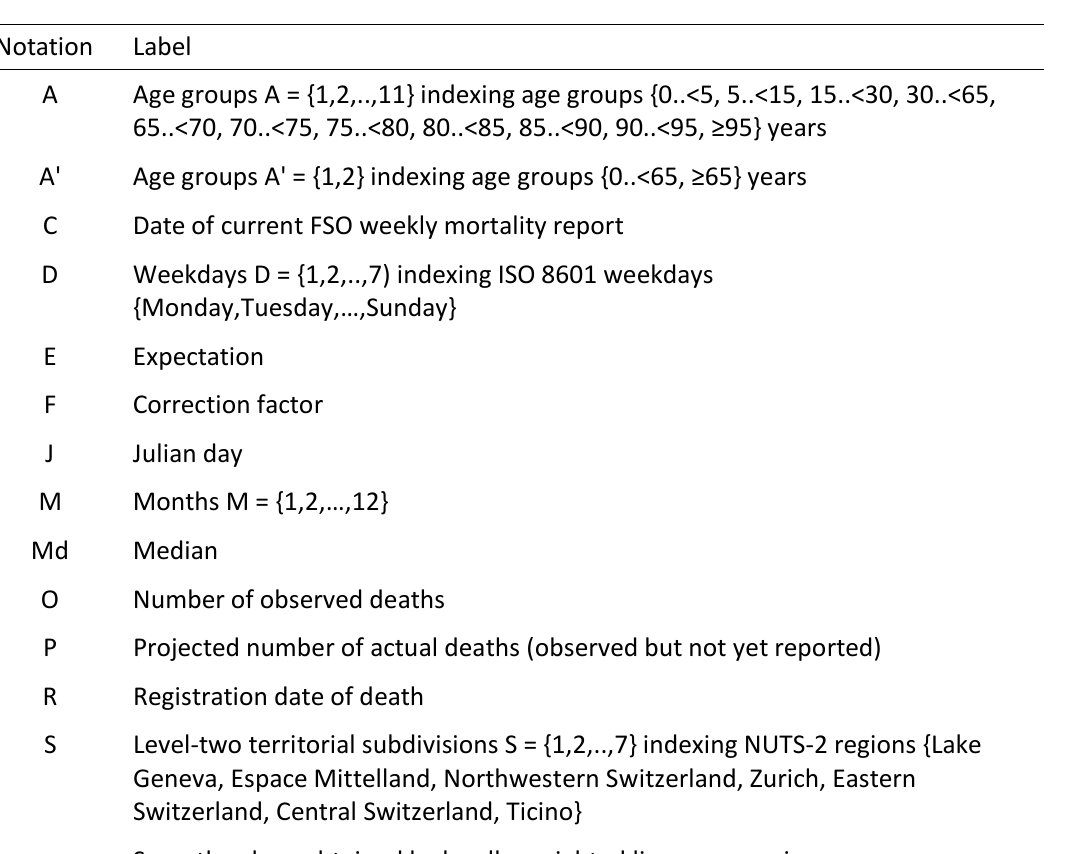
Table A1 : Definitions of abbreviations, variables, functions and statistics.